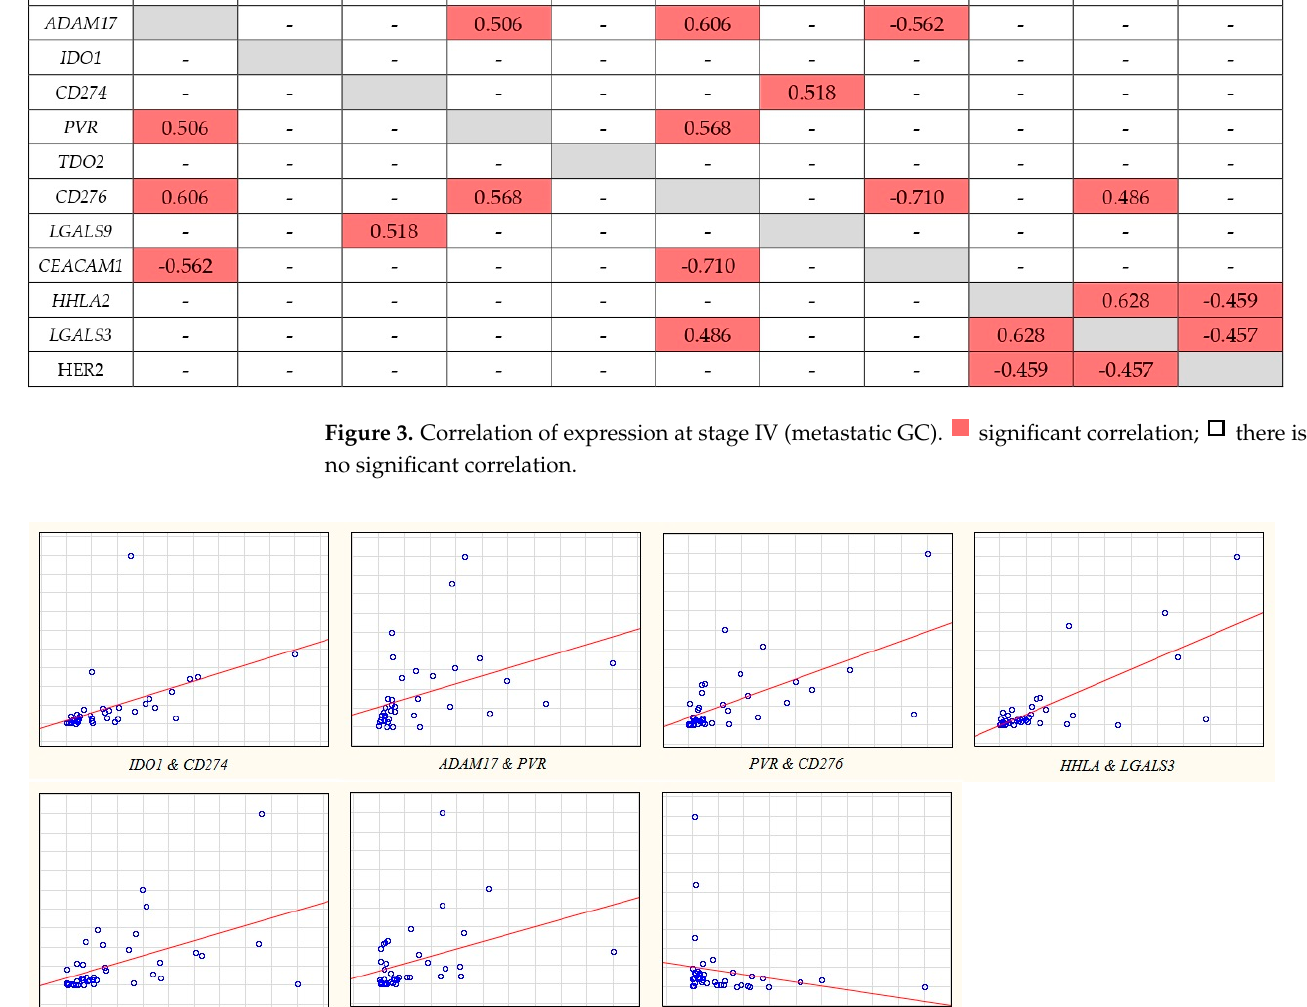
Figure 3. Correlation of expression at stage IV (metastatic GC). is no significant correlation.